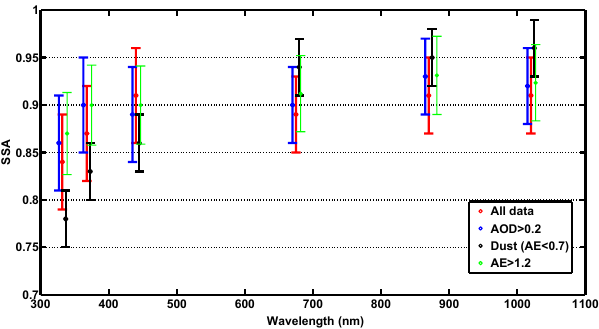
Figure 14. Wavelength dependence of SSA from synchronous CIMEL and UVMFR measurements. Blue points represent all data points, red points are data retrievals with AOD>0.2, green points are data with AE>1.2 and black points are data only dust aerosol cases. Vertical bars represent 1 standard deviation of the calculated